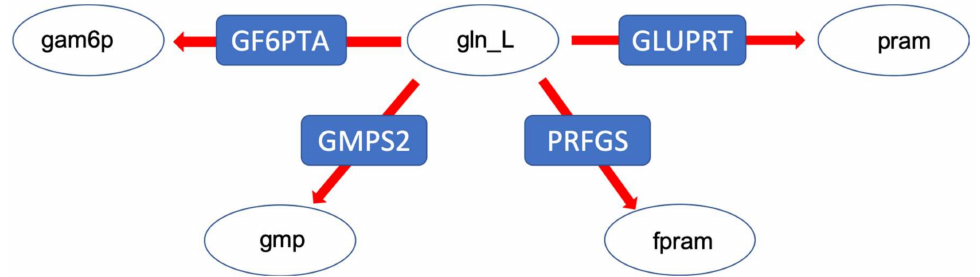
Figure 7. The glutamine branching point distributing amino-groups via the amino acid L-glutamine. Gln_L: glutamine, pram: 5-Phospho-beta-D-ribosylamine, fpram: 2-(Formamido)-N1-(5-phospho-D- ribosyl) acetamidine, gmp: guanosine monophosphate, gam6p: glucoseamine 6 phosphate.